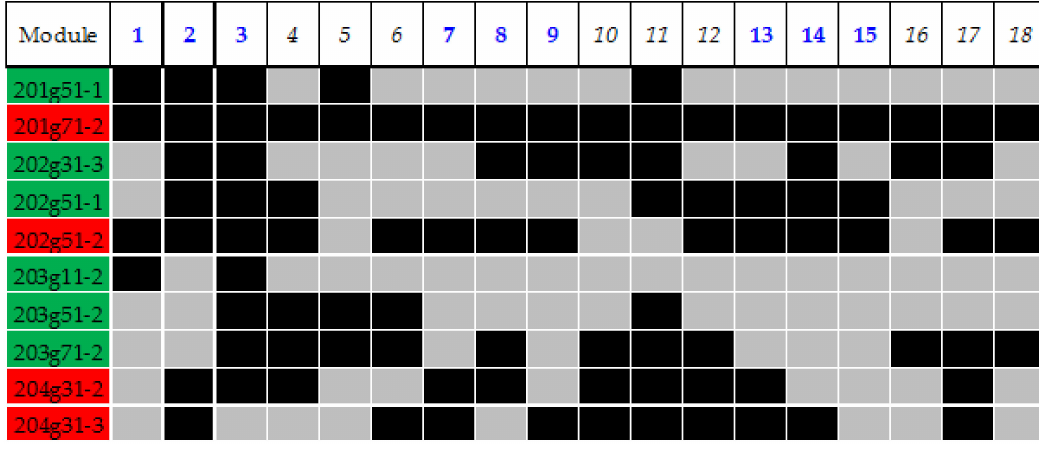
Figure 16. Diagram of working (grey) and inoperative (black) cells inside the modules after dehumidification.